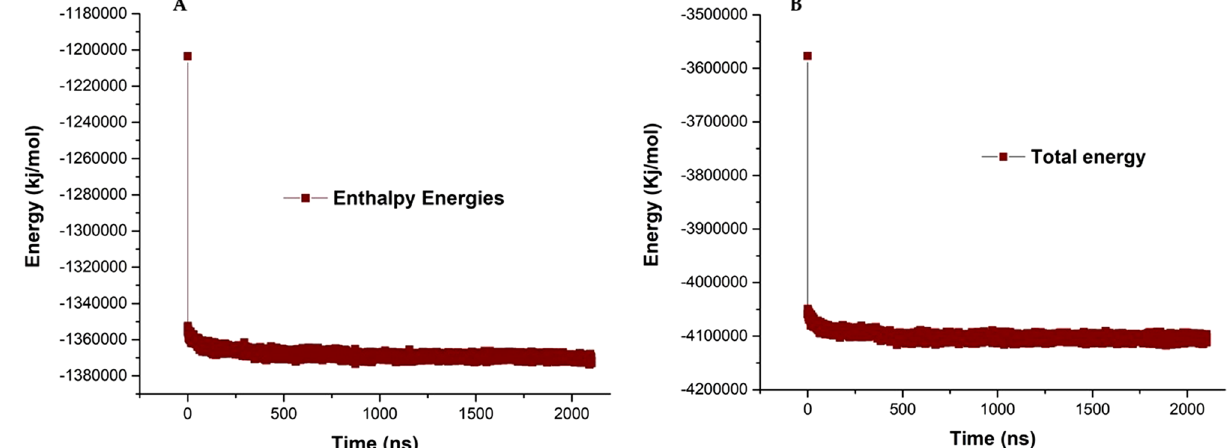
Figure 11. ( A ) Enthalpy energy of liposome model simulation system. ( B ) Total energy of liposome model simulation